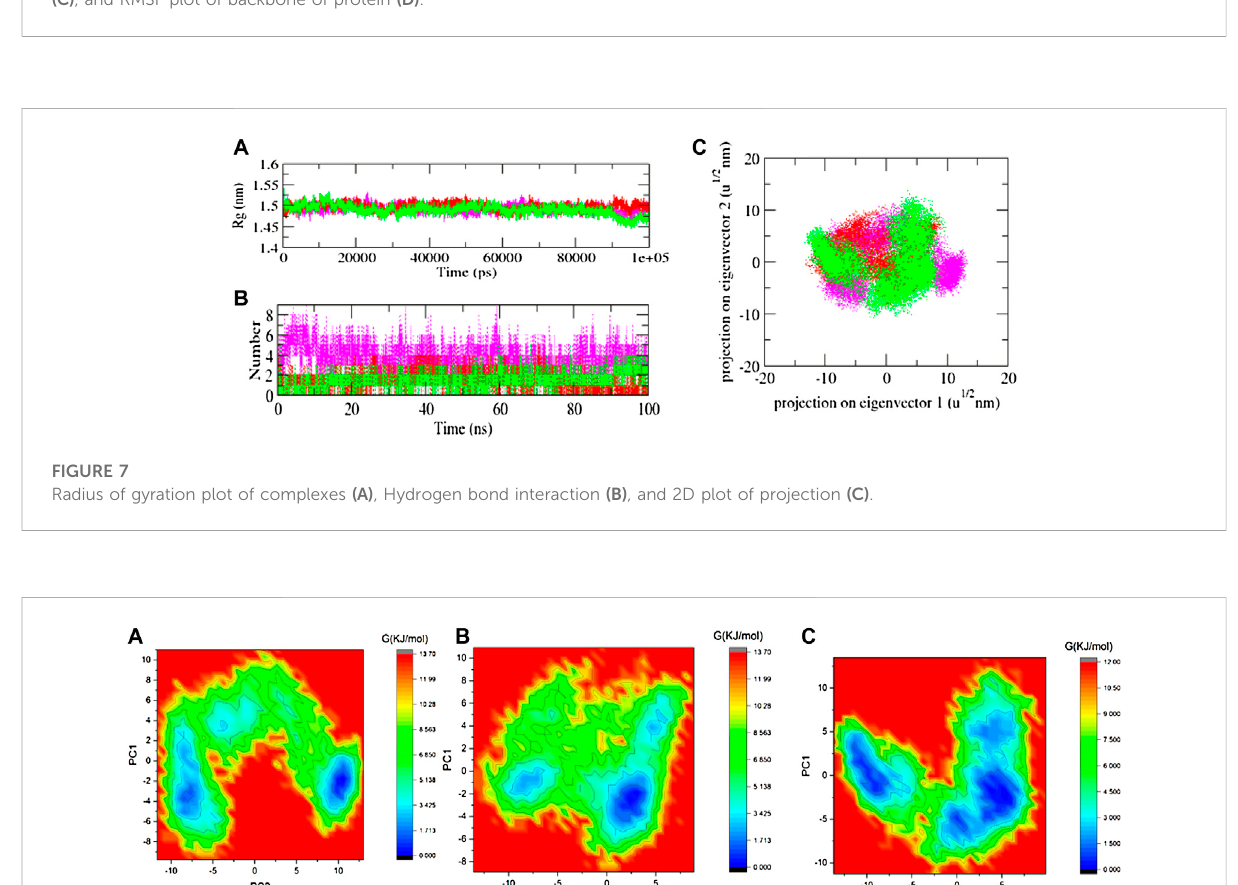
FIGURE 6 Structuralstabilitystudiesofcomplexes.3CLP-Sorafenib,3CLP-YM201636,and3CLP-controlcomplexesweredepictedinred,green,andpink color, respectively. RMSD plot of backbone ofproteinwith complexes (A) , RMSD plot ofligands within pocket of protein (B) , SASAplot ofcomplexes (C) , and RMSF plot of backbone of protein (D) .